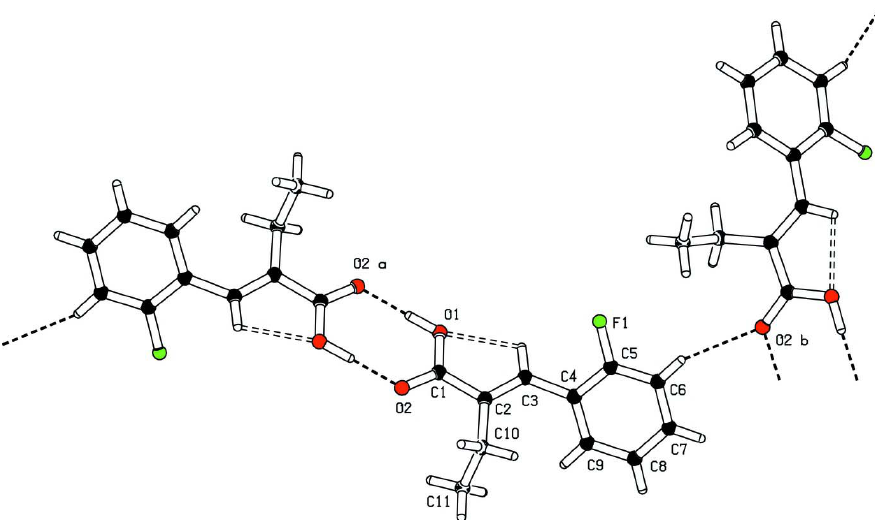
H F O with the atom numbering scheme. The thermal ellipsoids are drawn at 11 11 1 2